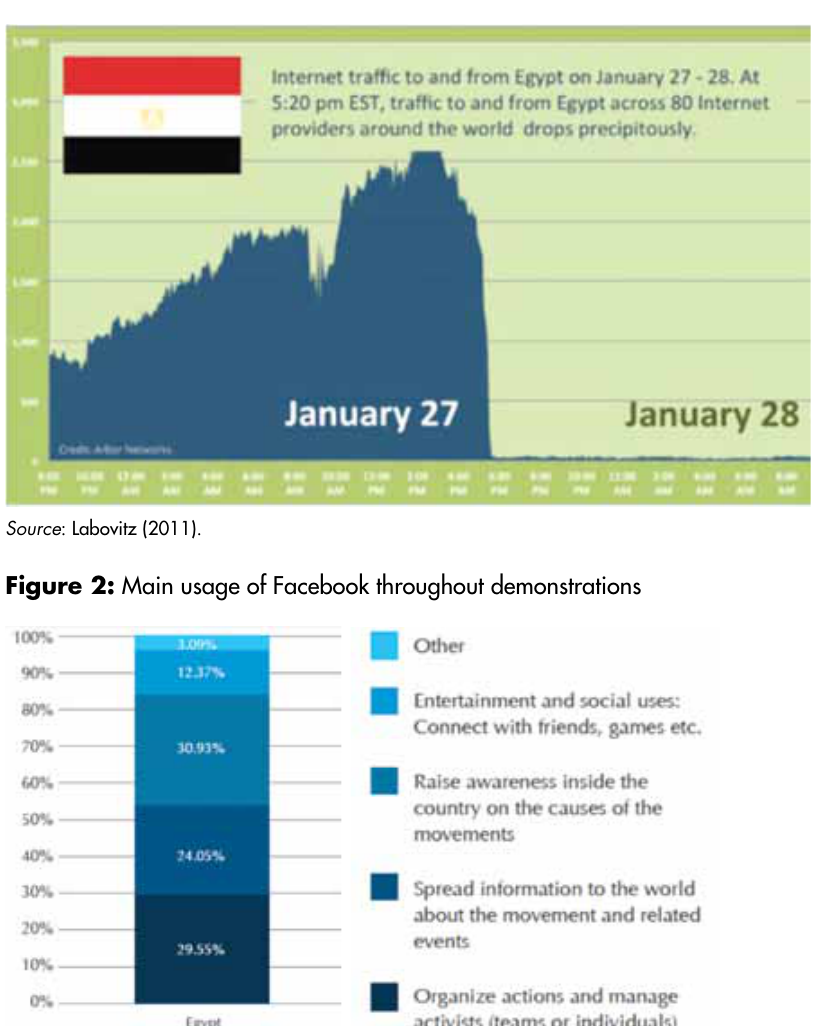
Figure 1 : The internet blackout in Egypt on 28 January